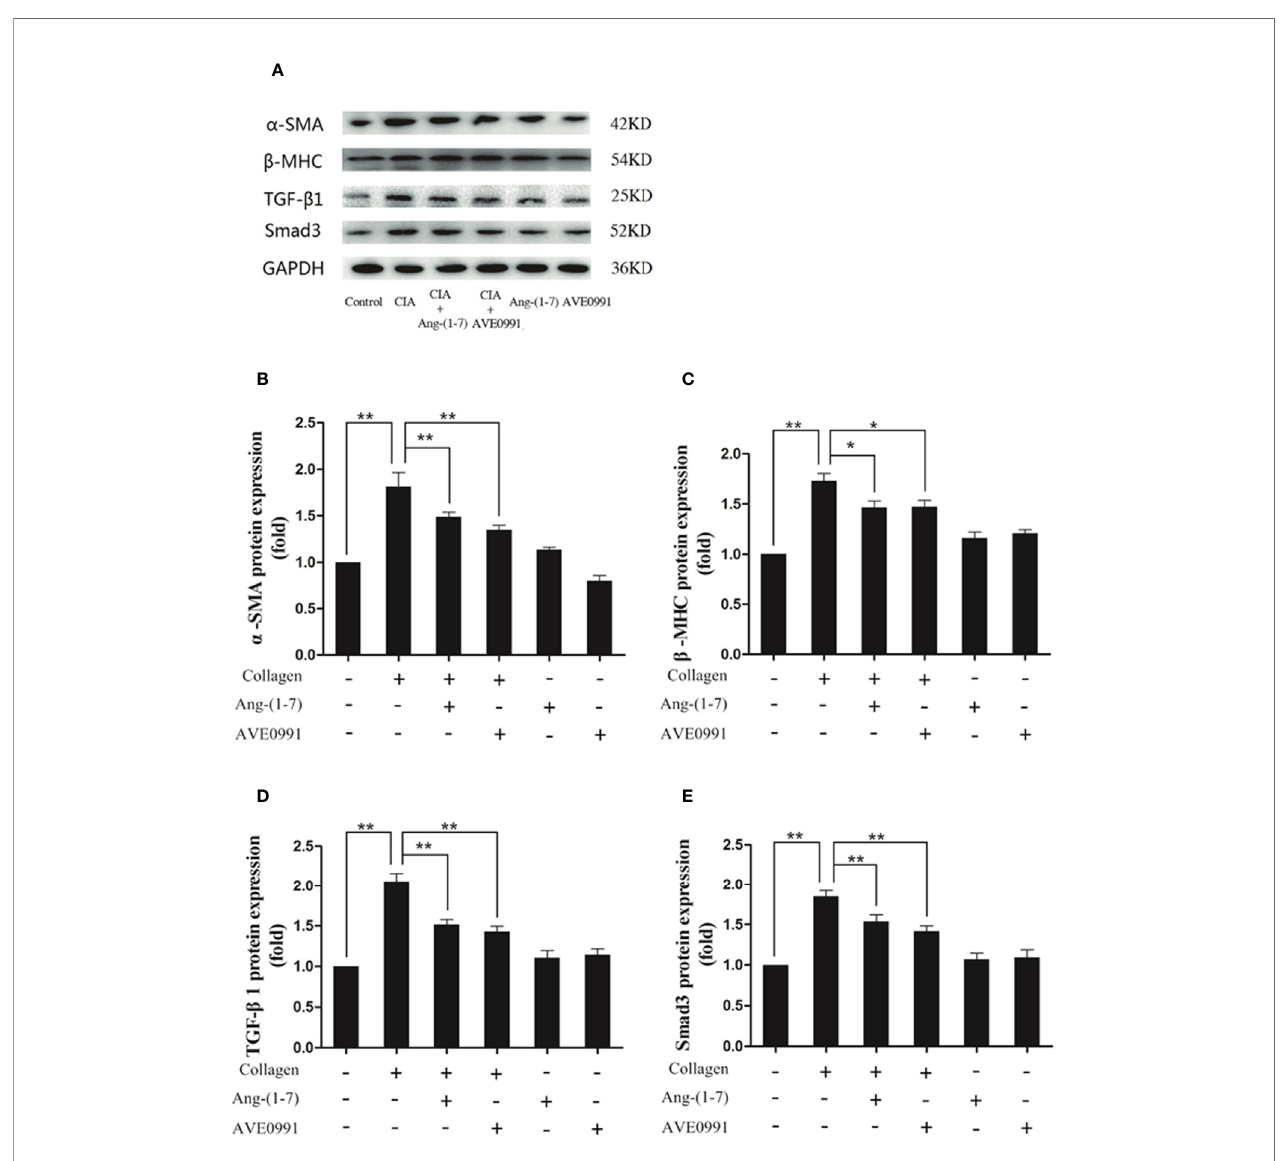
FIGURE 7 | Ang-(1 – 7) and AVE0991 inhibit a -SMA 、 b -MHC 、 TGF- b 1 and Smad3 protein expression in heart of CIA model. (A) Representative immunoblots for a -SMA 、 b -MHC 、 TGF- b 1, and Smad3. (B) Representative quantitative analysis of a -SMA. (C) Representative quantitative analysis of b -MHC. (D) Representative quantitative analysis of TGF- b 1. (E) Representative quantitative analysis of Smad3. Values are expressed as means ± SD (n = 6). *P < 0.05, **P <